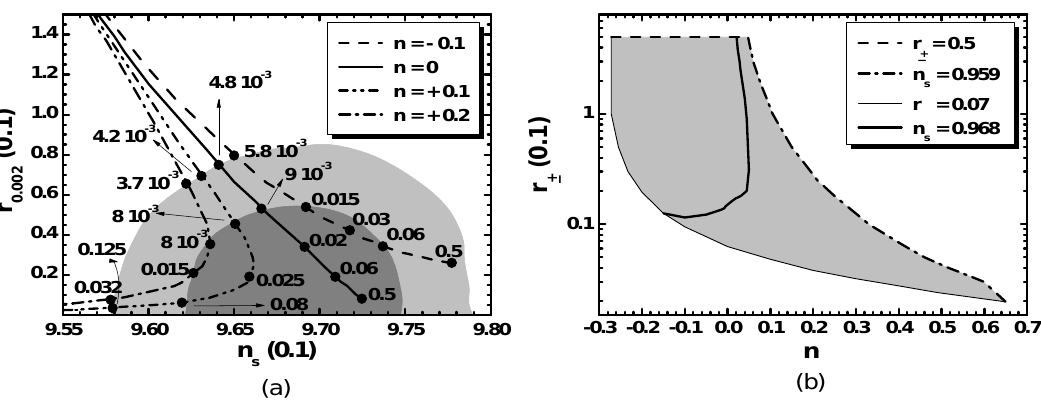
r 0.002 plane for K = K 2 and K 3 , n = −